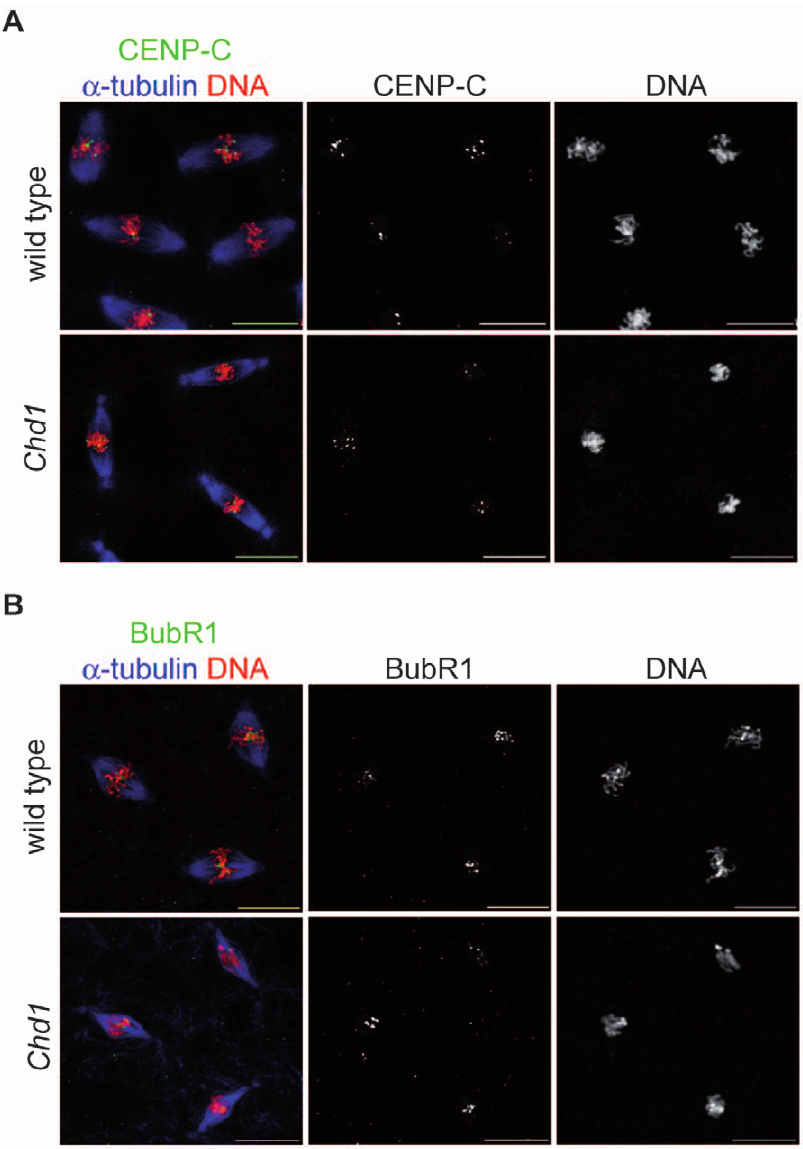
Figure 6. Recruitment of kinetochore components is not disturbed in the absence of CHD1. Wild-type and Chd1 null embryos were stained with antibodies against a -tubulin (blue) and either the inner kinetochore protein CENP-C (A) or the outer kinetochore protein BubR1 (B; both in green). DNA was counterstained with propidium iodide (red). Neither CENP-C nor BubR1 show apparent localization defects in the absence of CHD1. Scale bars =10 m